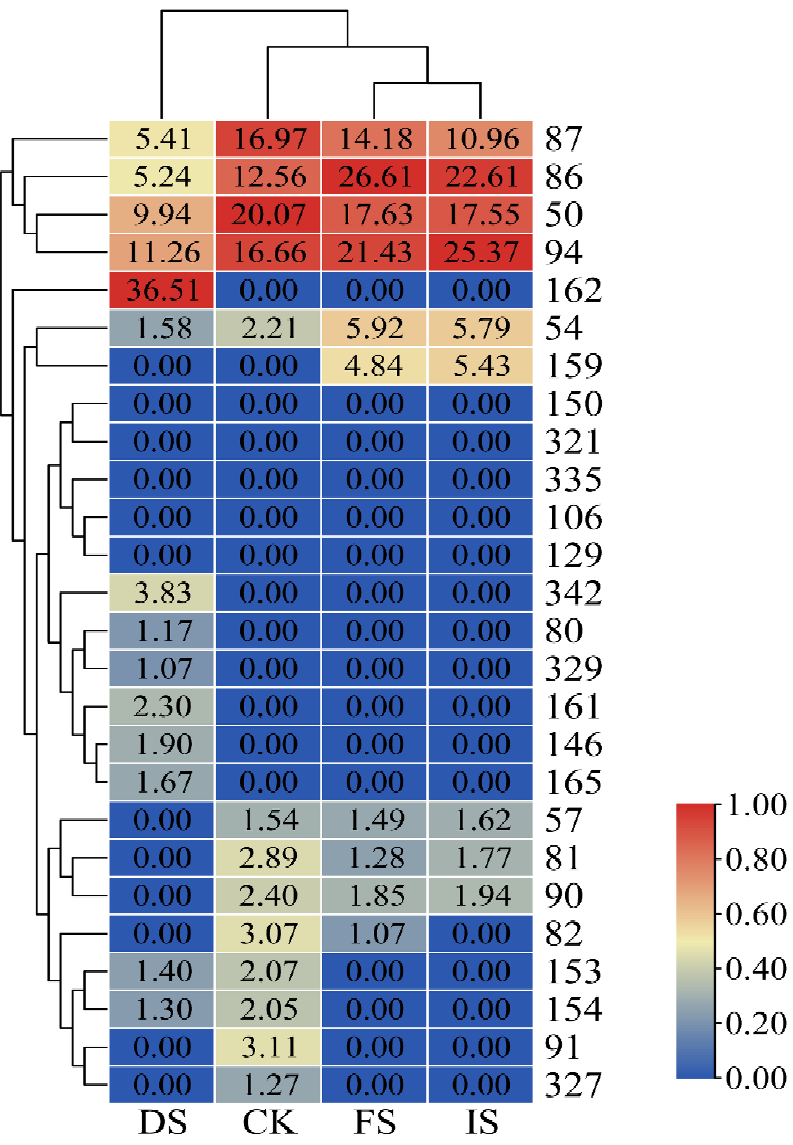
Figure 6. Average relative abundances of fungal ITS rDNA T-RFs in soil samples treated with different forms of Tateges erecta . CK: replanted soil, DS: air-dried T. erecta sample, FS: fresh T. erecta sample, IS: infusion solution of fresh T. erecta .